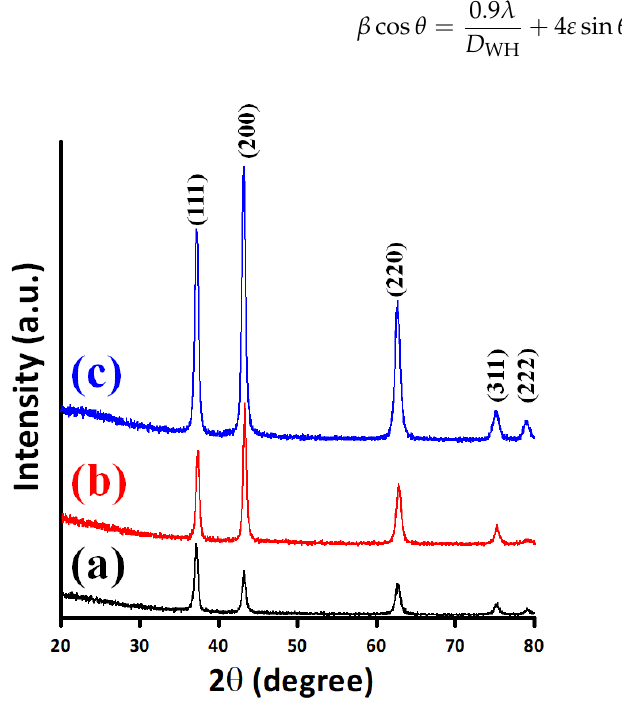
Figure 1. XRD patterns of NiO films deposited at various substrate temperatures of (a) 300 °C, (b) 400 °C, and (c) 500 °C.